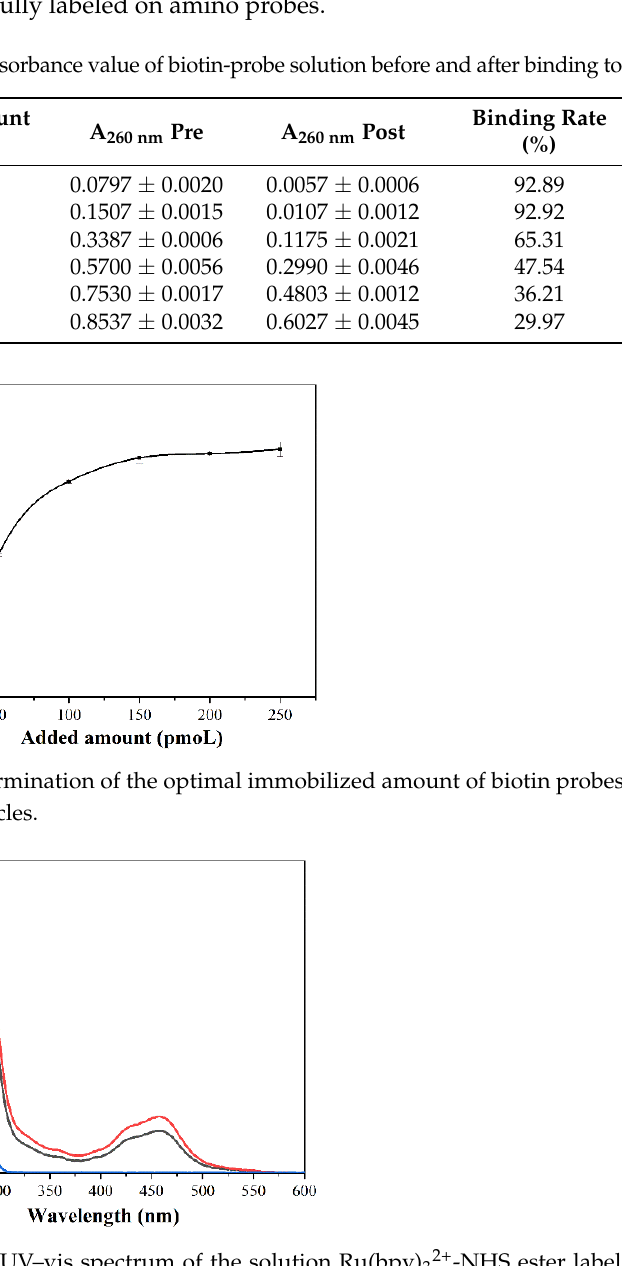
( b ) Figure 4. ( a ) Standard curve of detecting different concentrations of the nucleic acid of SARS-CoV- 2 using an ECL biosensor based on dual-probe hybridization. ( b ) The response curve of detecting different concentrations of the nucleic acid of SARS-CoV-2 using an ECL biosensor based on dual- probe hybridization. 3.4. Reproducibility and Specificity Examination In the linear range of the detection, the concentrations of the ORF1ab target gene at concentrations of 10 pM, 10 nM, and 10 µM were selected for the above dual-probe hybridization reactions. The ECL intensity was measured five times for each one, and the